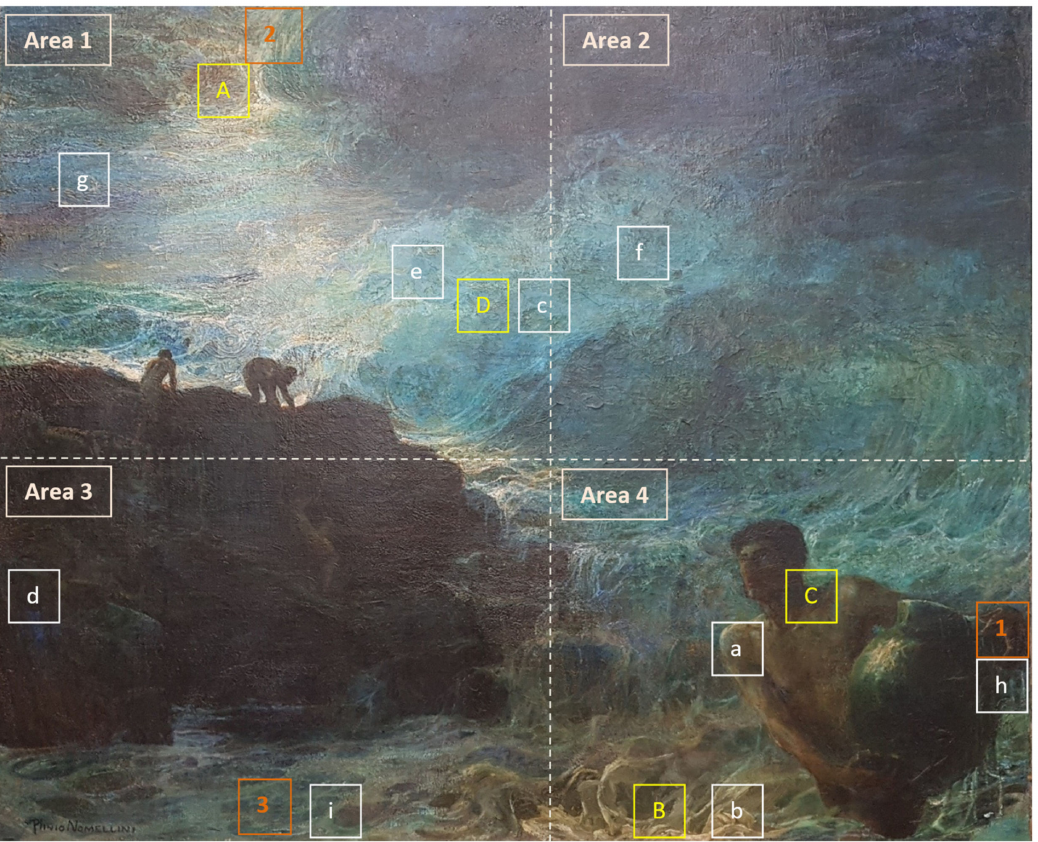
Figure 1. Plinio Nomellini, I Tesori del Mare (1901), 127 × 108 cm, Galleria Nazionale d’Arte Moderna e Contemporanea, Rome (IT). Image before the intervention with the indication of the investigated areas: sampling areas (1, 2, 3); acquisitions with DinoLite optical microscope (a–i); areas analyzed using Raman spectrometer (A–D); areas examined using Multispectral Imaging (Area 1–Area